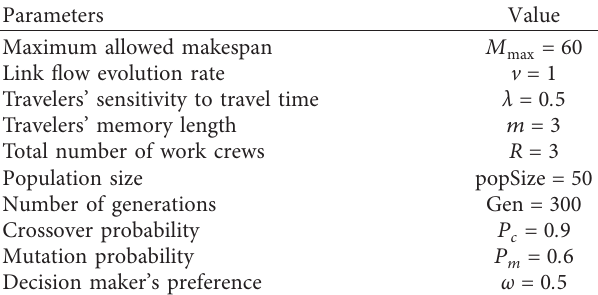
Table 3: Parameter values used in this